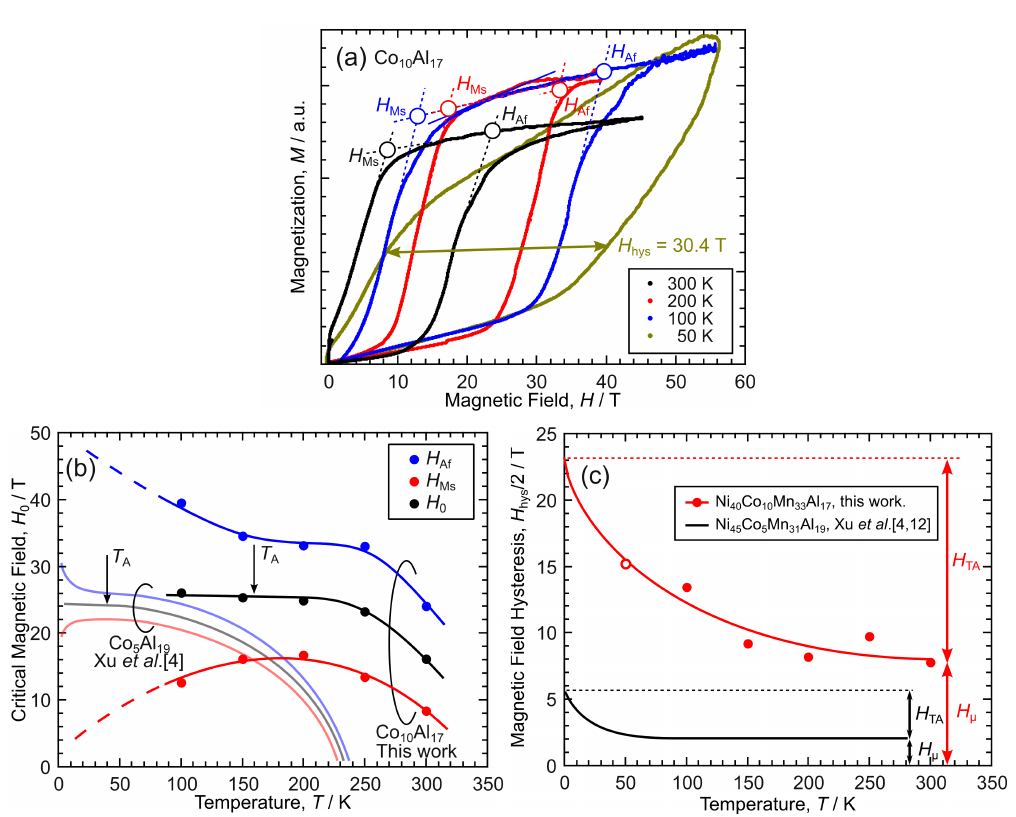
and shown by an open hys